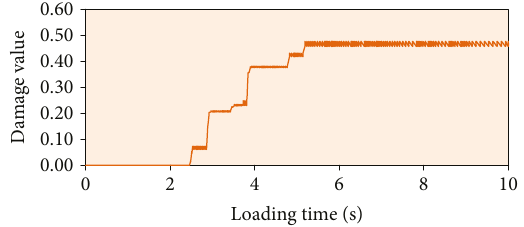
Figure 23: Damage time-interval curve at dam